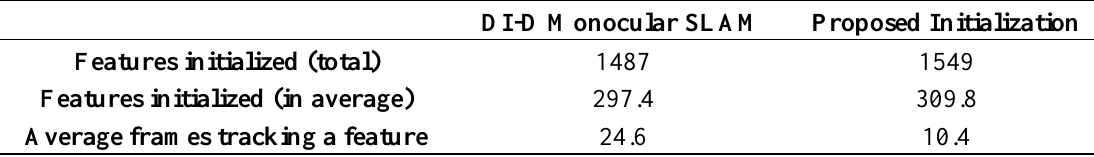
Table 2. Statistics of features used and frames being tracked until